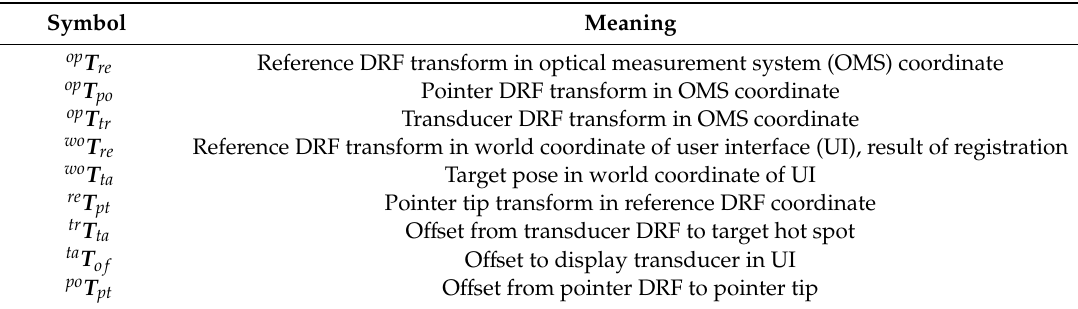
Figure 7. Two schematic figures represent coordinate transform between several coordinate frames. ( a ) describes how the pose data of the pointer dynamic reference frame (DRF) with respect to the reference DRF is obtained. For the registration, corresponding fiducial point sets both in the real world and in the GUI are needed. ( b ) After the registration, the combination of the several coordinate frames to display the transducer in the navigation program is described. Table 1. Explanation of coordinate frames used in coordinate transform.